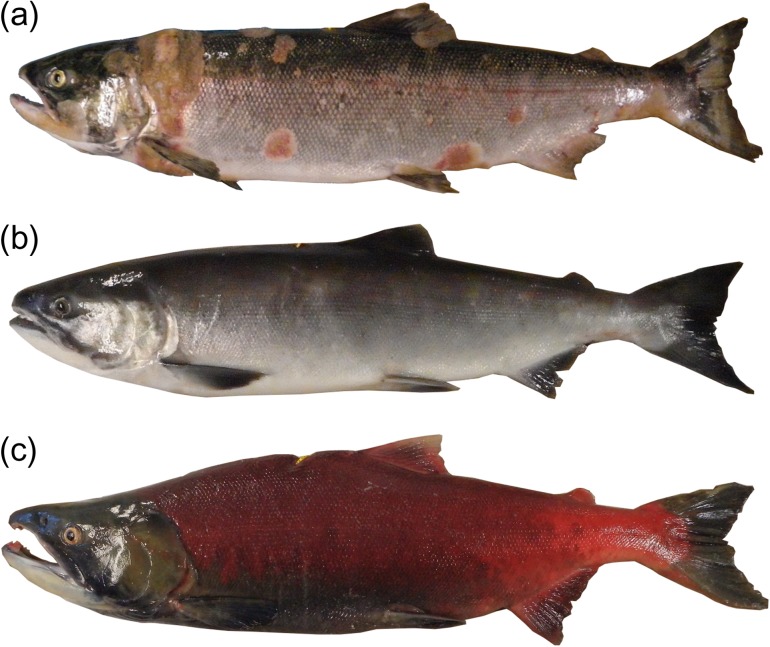
Three examples of Early Stuart sockeye exposed to experimental gillnet entanglement: (a) a prematurely moribund male showing severe necrosis and Saprolegnia spp. fungal infections, (b) a surviving male lacking secondary sexual characteristics and mild gillnet scarring posterior to the operculum and (c) a surviving male with well-developed secondary sexual characteristics and ventral gillnet scarring anterior to the dorsal fin.